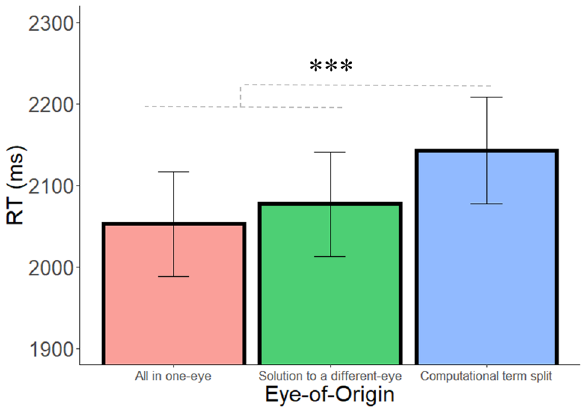
Figure 3. RT as a function of eye-of-origin in Experiment 1. Error bars = SEM. *** = p <